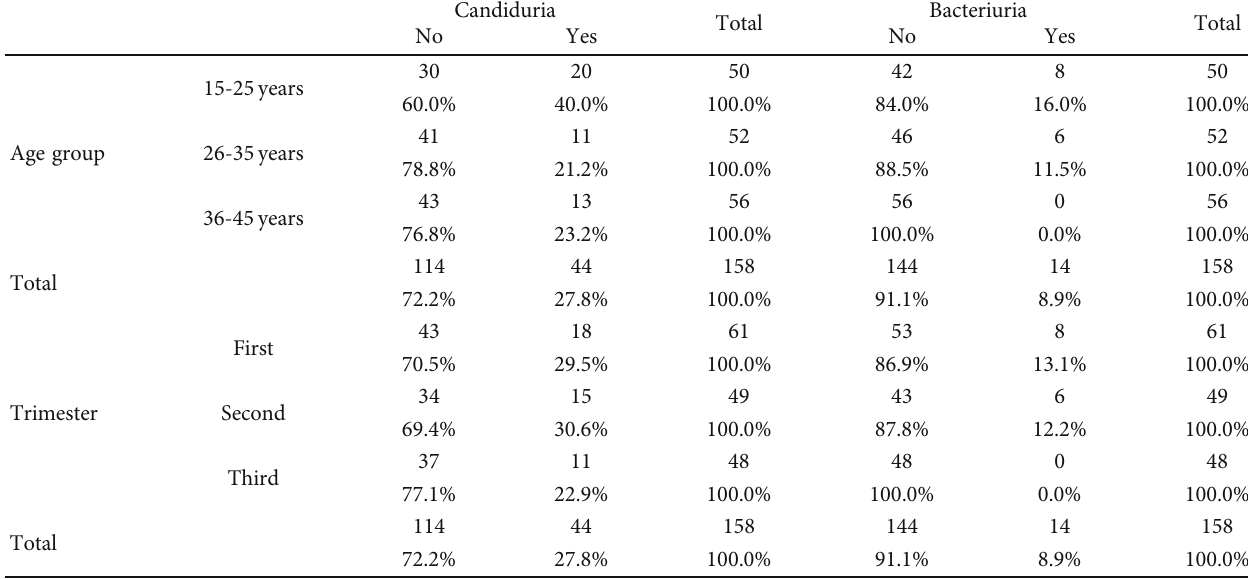
Table 4: Association between maternal age, stage of pregnancy, and identi fi ed microorganism.